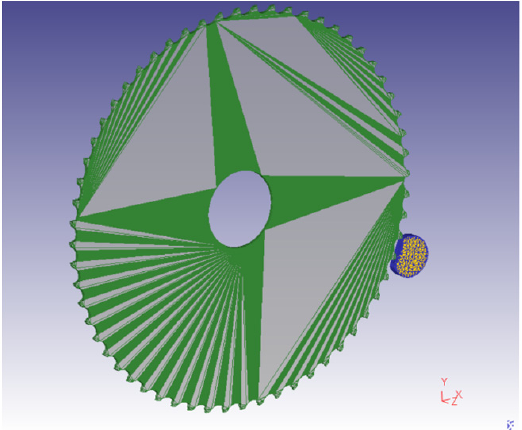
Figure 7. Mesh generation of saw blade and workpiece.